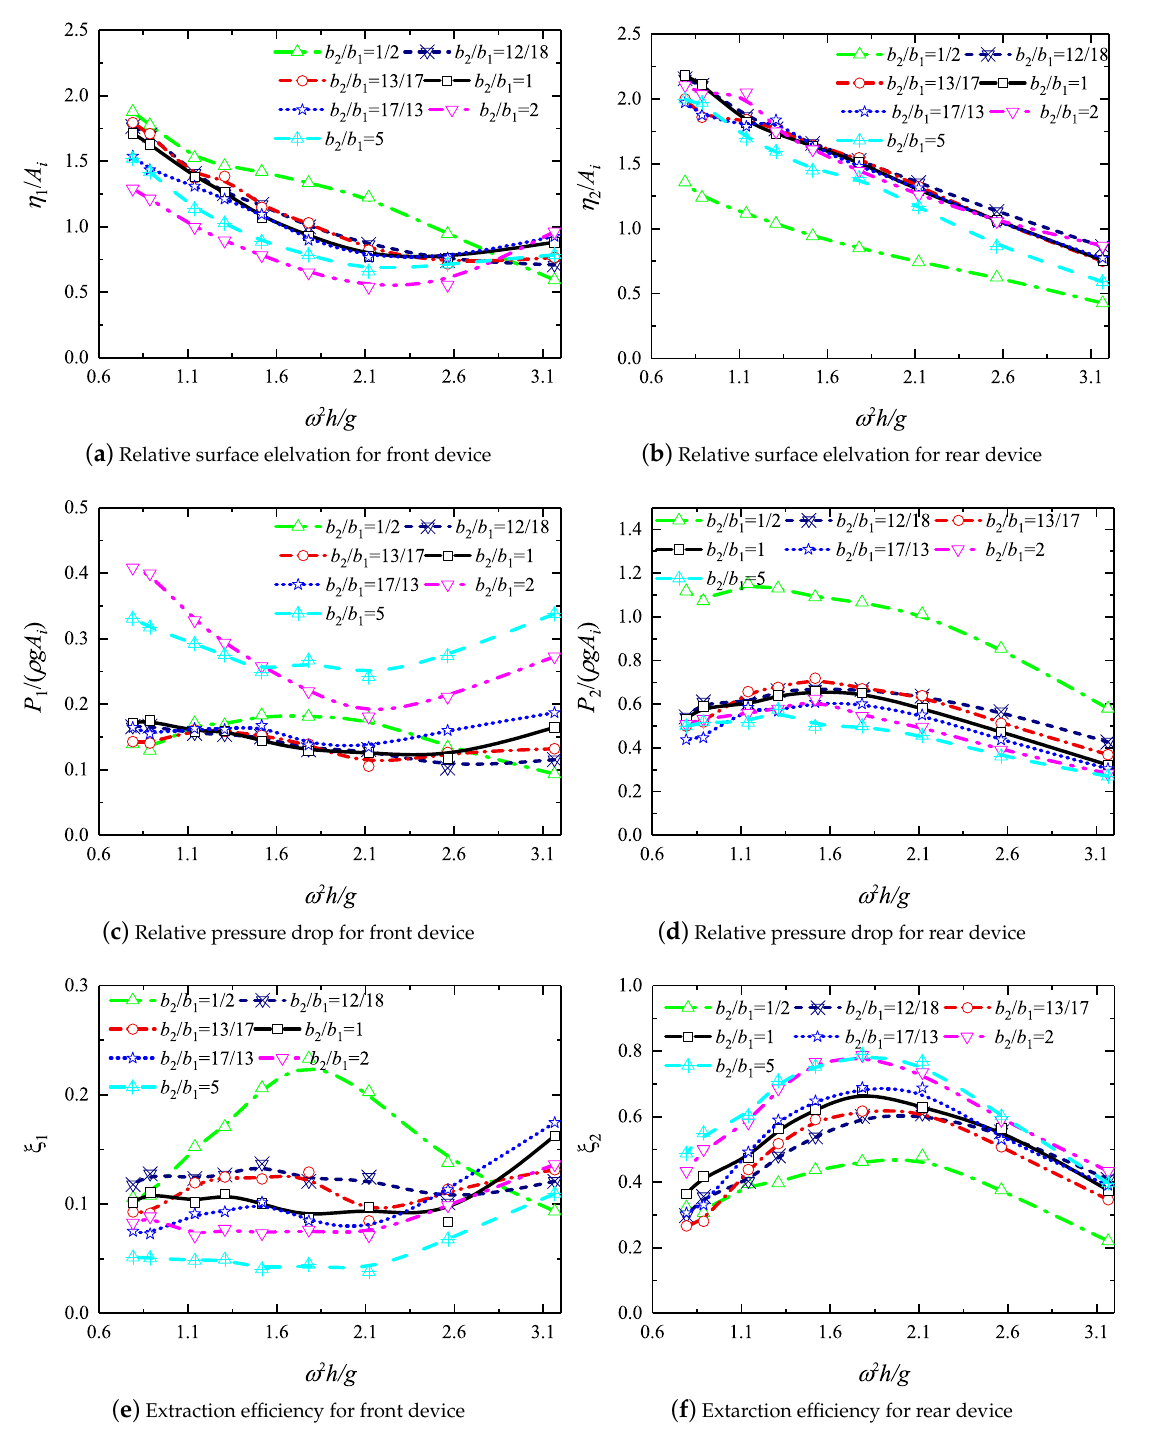
Figure 11. Relative surface elevations, relative pressure drops and extraction efficiencies of the front and rear devices for different chamber